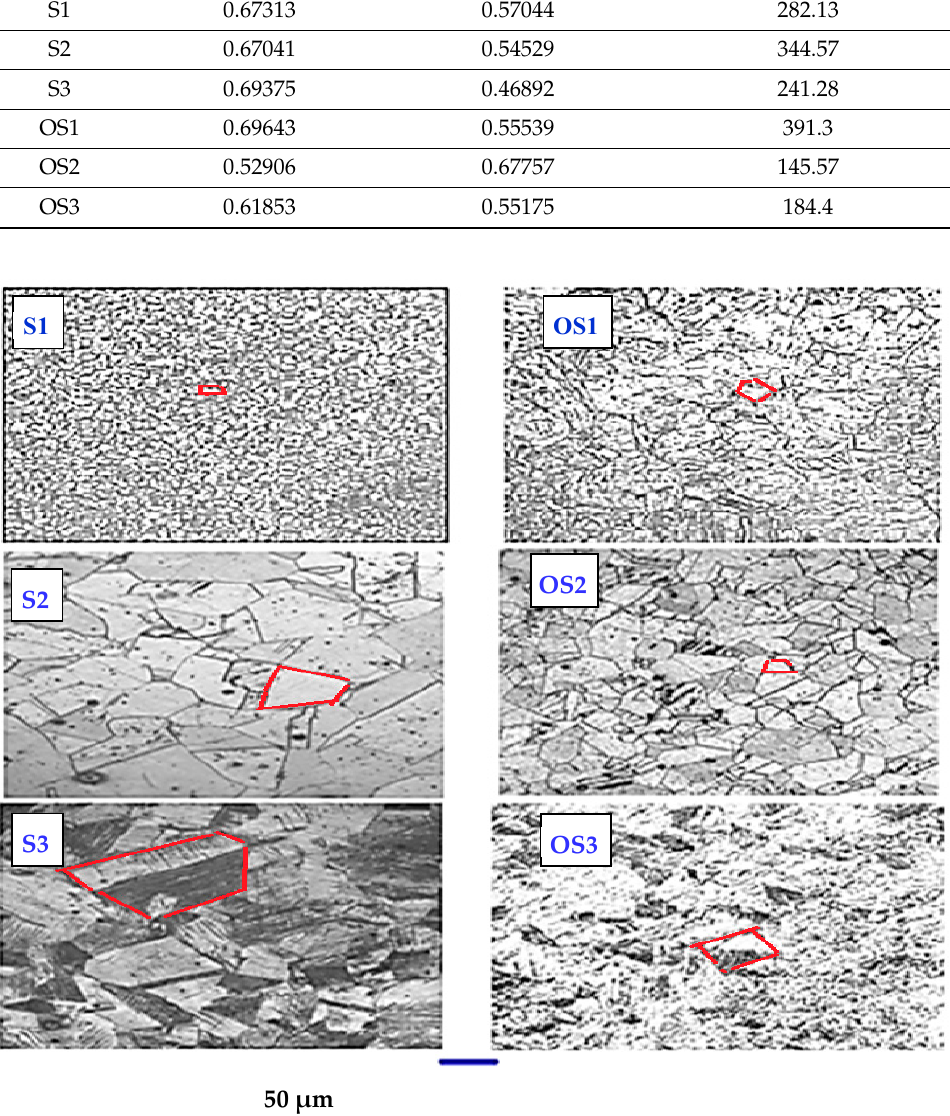
Figure 4. Optical microstructure for investigated materials, before and after the heat-treatment process magnification 20 ×